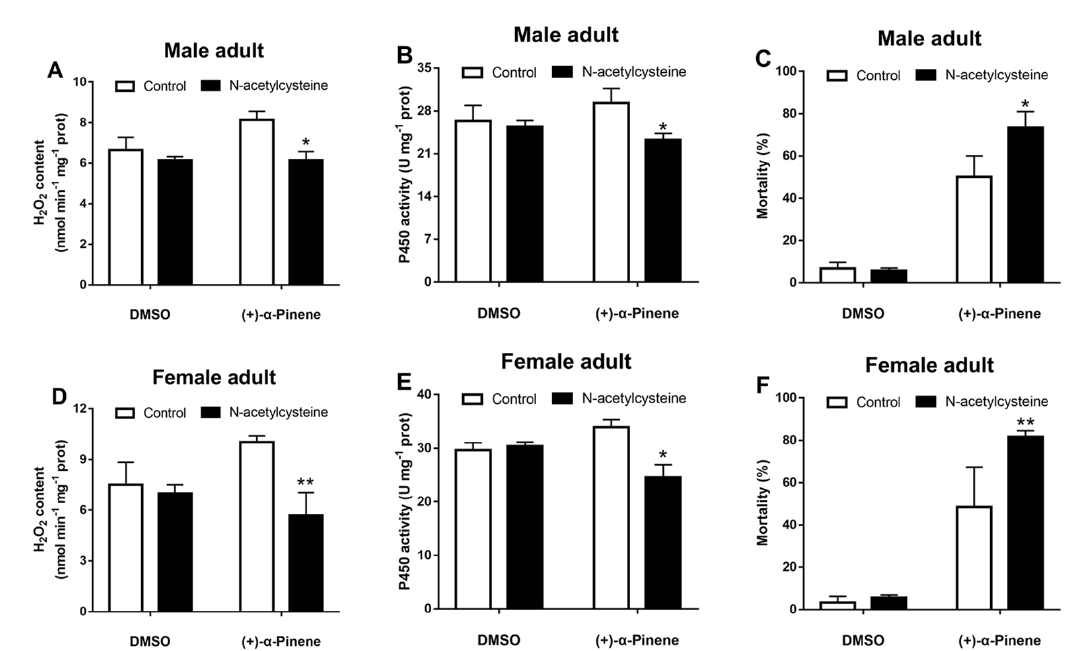
Figure 7. Effects of ROS scavenging on the adults’ tolerance to (+)- α -pinene in D. armandi. The adults of D. armandi reared on normal (control) or 2% NAC diets were treated with DMSO or (+)- α -pinene for 24 h. The H 2 O 2 content ( A , D ) and the activities of P450 ( B , E ) in the midgut of adults were determined spectrophotometrically. ( C , F ) Adults were further treated with (+)- α -pinene, and mortalities were assessed after 24 h. The asterisk indicates a significant difference between different treatment groups (* p < 0.05, ** p < 0.01, independent Student’s t -test). All values are the mean ± SE, n = 3.